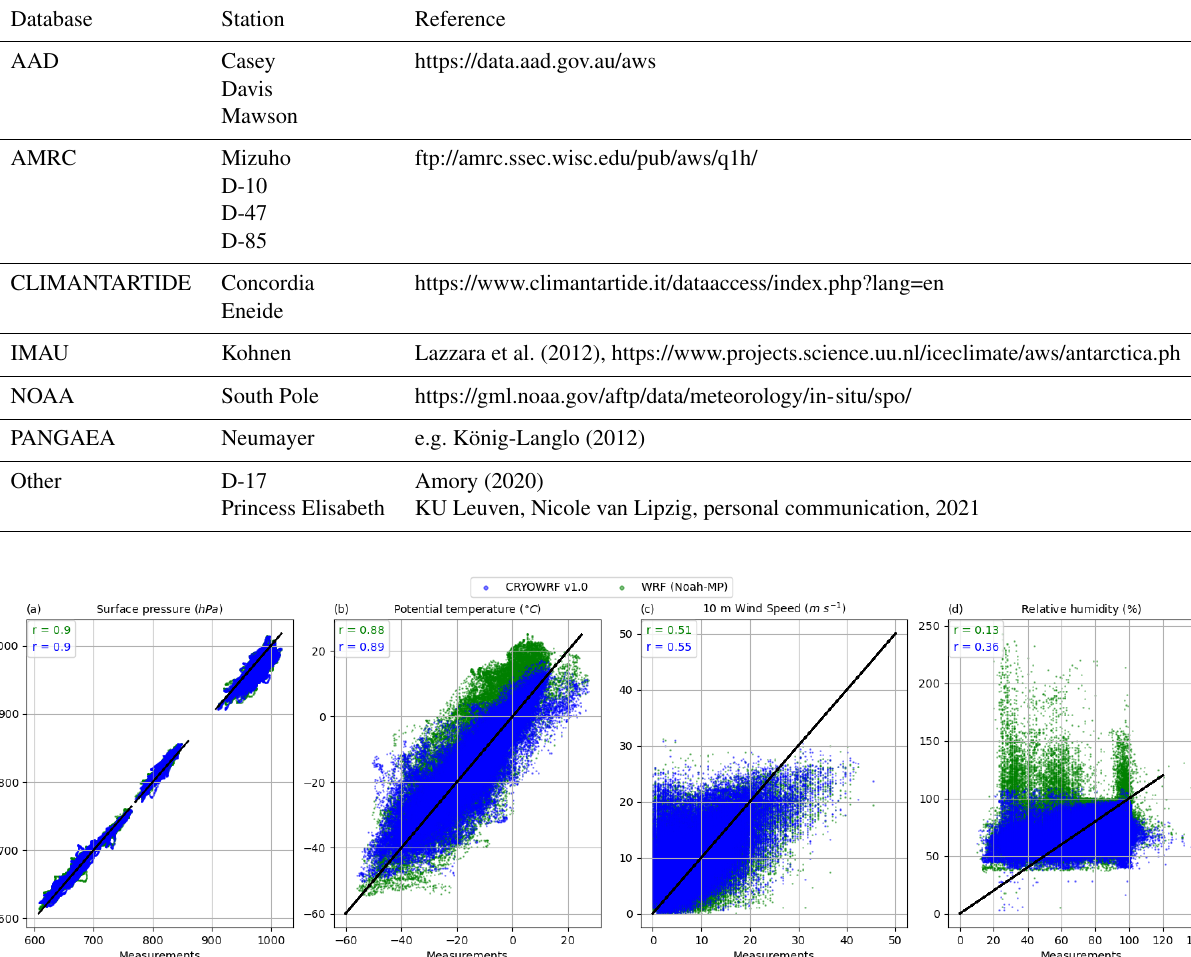
Table 1. Atmospheric weather stations used for model verification. Last access for all URLs: 3 December 2022. Database